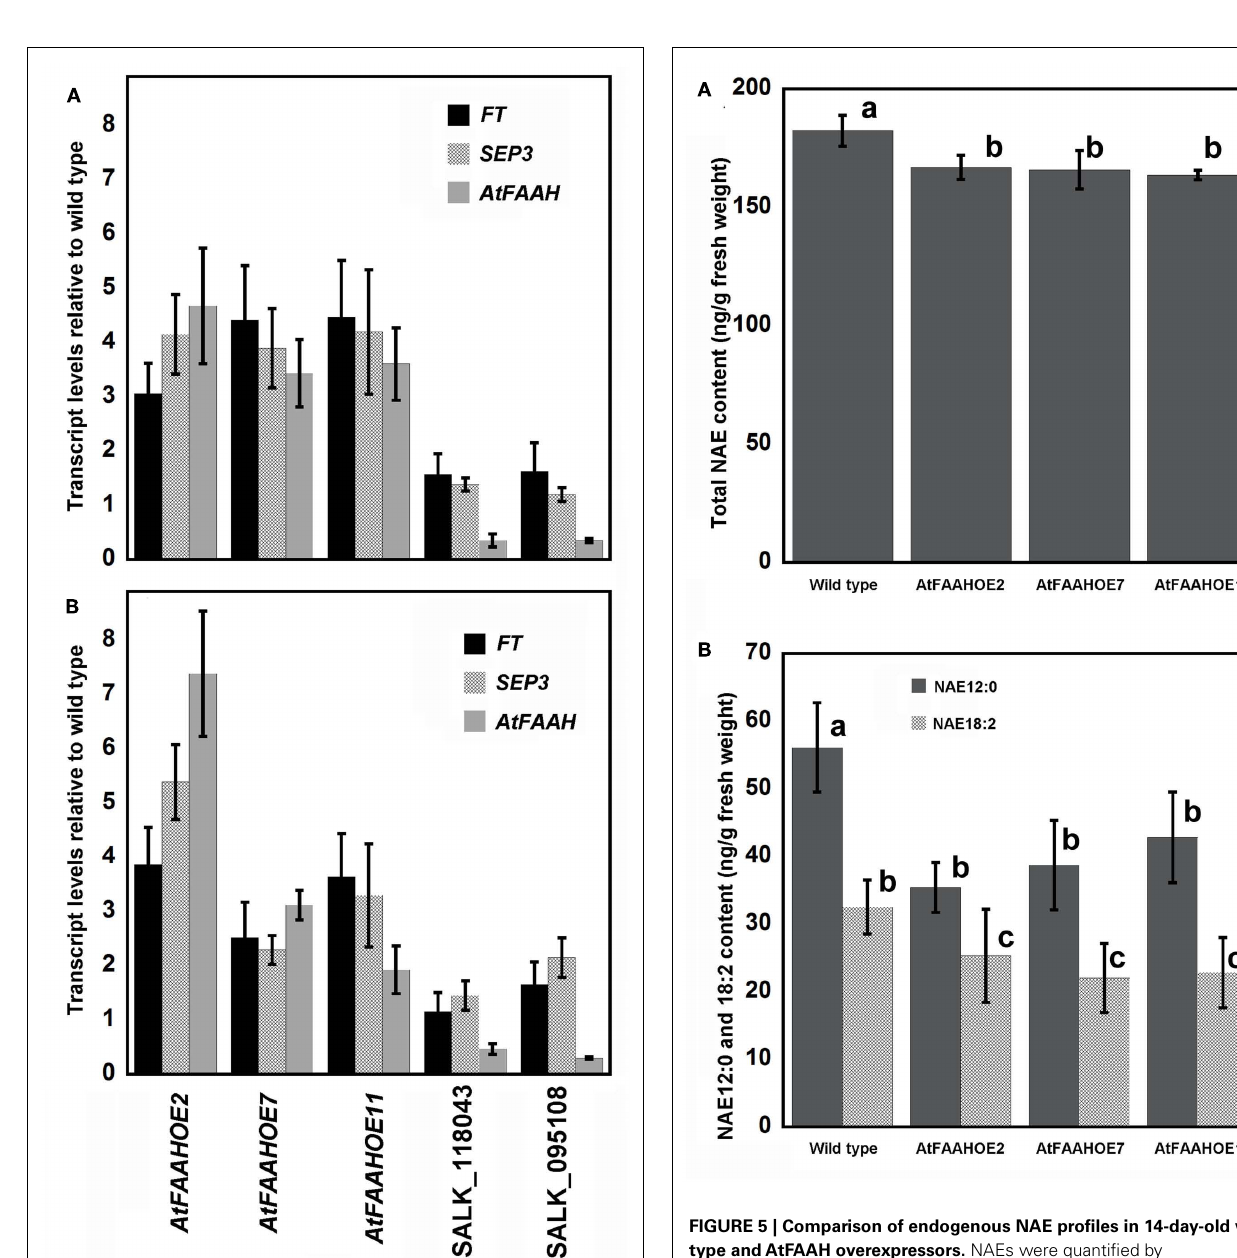
FIGURE 5 | Comparison of endogenous NAE profiles in 14-day-old wild type andAtFAAH overexpressors. NAEs were quantified by isotope-dilution mass spectrometry and summed for total NAE content (A) and total NAE 12:0 and NAE 18:2 (B) .Values represent the mean ± SE of three individual extractions from 14-day-old seedlings grown under short days. Mean ± SE with different letters are significantly different ( p < 0.005; Tukey’s